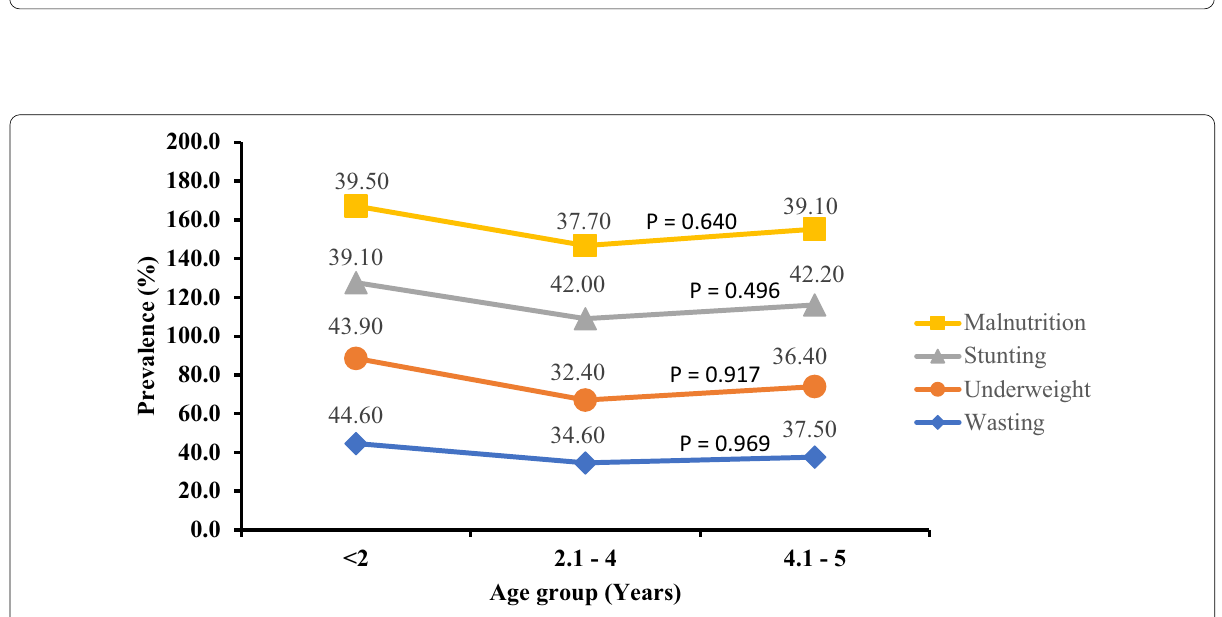
Fig. 2 Prevalence of malnutrition and its categories with respect to